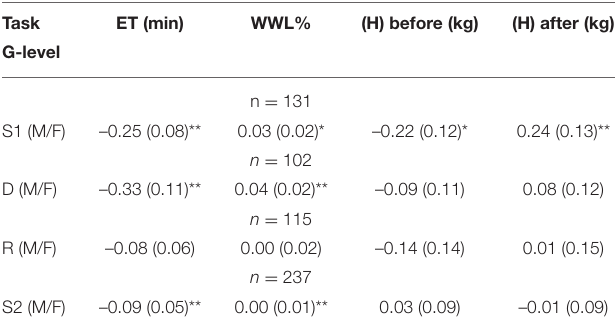
TABLE 5 | The ET (min) and WWL% predictors of different types of tasks under 1G, 1 ⁄ 3 G, 1 ⁄ 6 G.